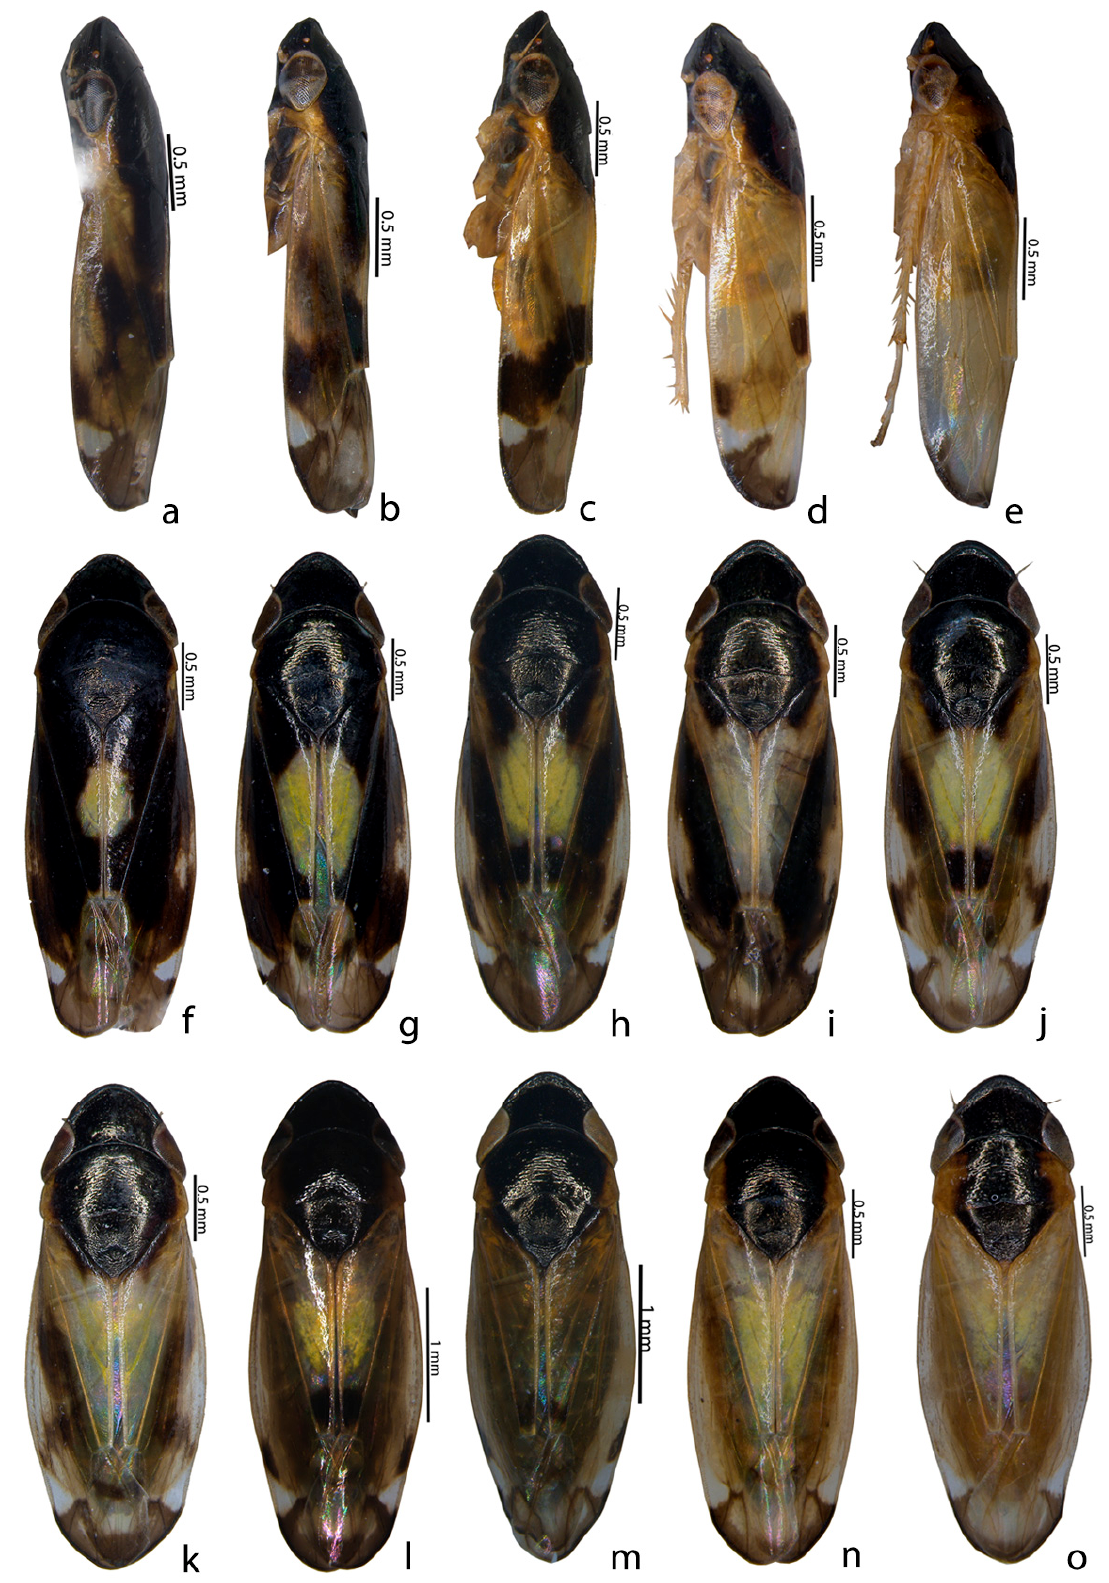
Figure 2. Colour polymorphism in Mukaria splendida Distant. ( a – e ) ♂ lateral habitus; ( f – o ) ♀ dorsal habitus.